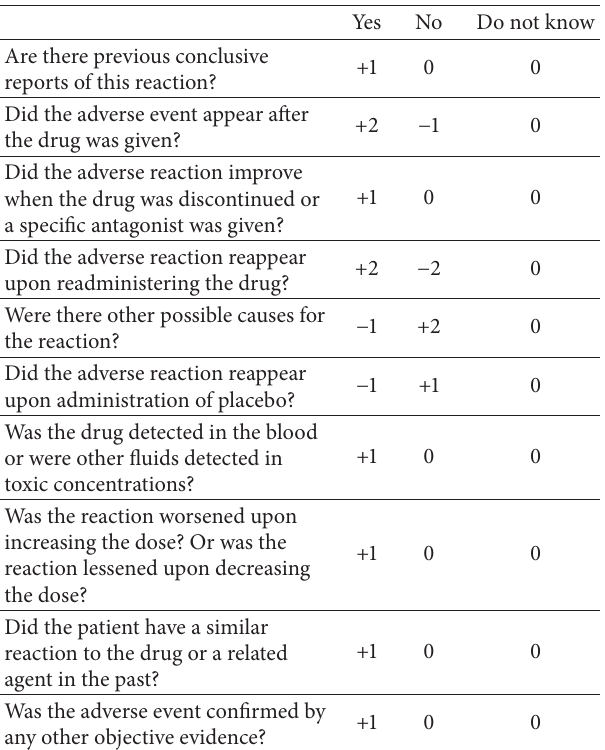
Table 2: Naranjo probability scale. Total scores range from − 4 to +13; the reaction is considered definite if the score is 9 or